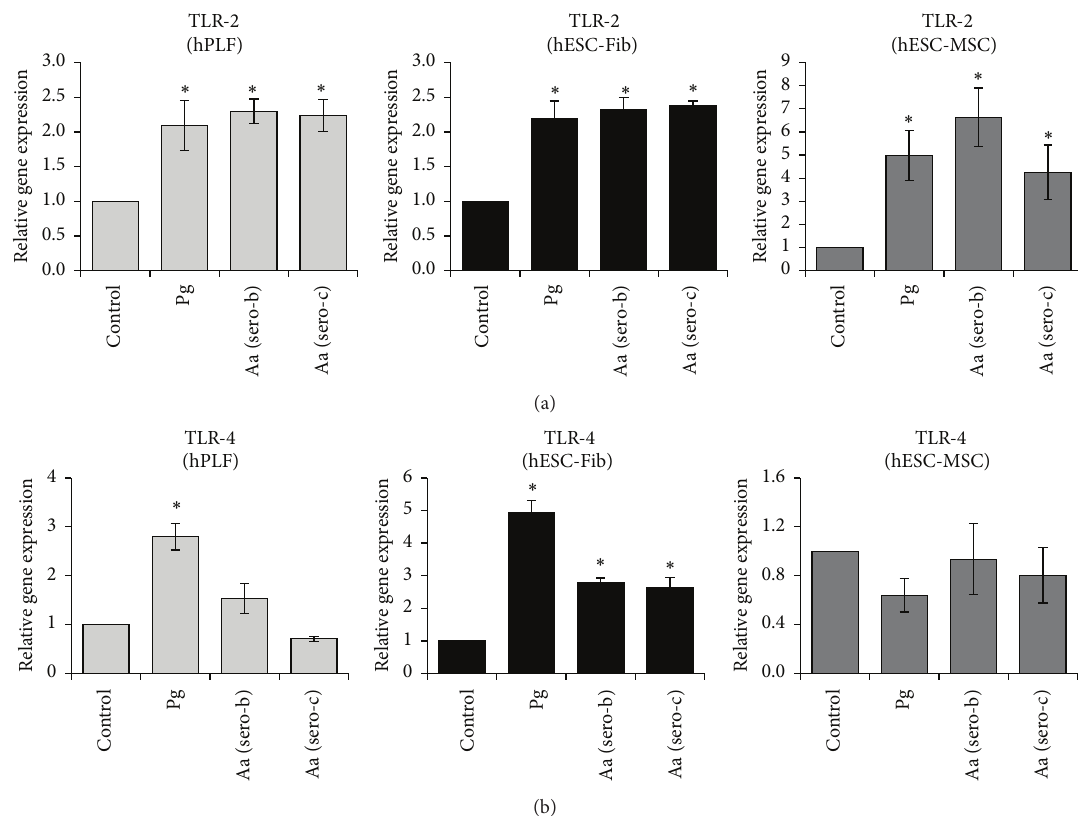
Figure 5: Transcript expression profiles of TLR-2 (a) and TLR-4 (b) among hPLFs, hESC-Fib, and hESC-MSCs in response to exposure to P. gingivalis (Pg) and two different serotypes of A. actinomycetemcomitans (Aa serotypes b and c). The transcript levels were normalized to the respective 𝛽 -actin levels and to the untreated control sample. Values represent the means ± SD of three experiments ( ∗ 𝑝 < 0.05 versus untreated